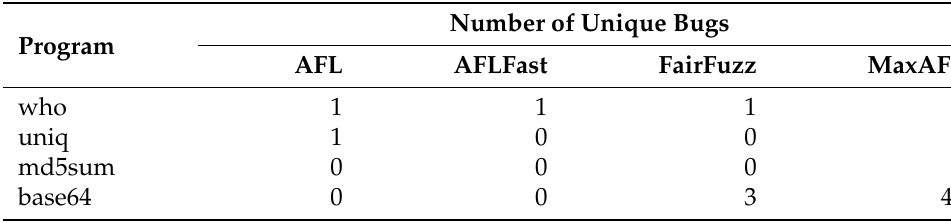
Table 4. Number of unique crashes found by each fuzzer.